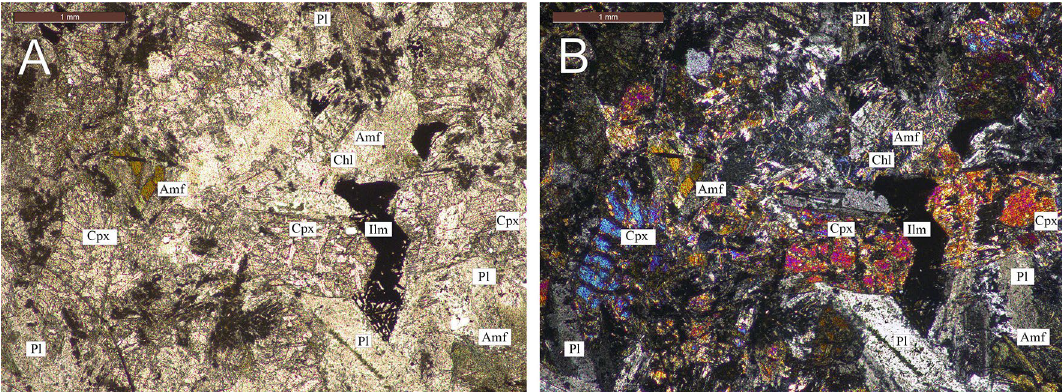
Figure 4. Photomicrograph of sample N595 (Gornostakh dyke). ( A ) Transmitted polarized light. ( B ) Cross- polarized light. Pl = plagioclase, Cpx = clinopyroxene, Amf = amphibole, Chl = chorite, Ilm = ilmenite.